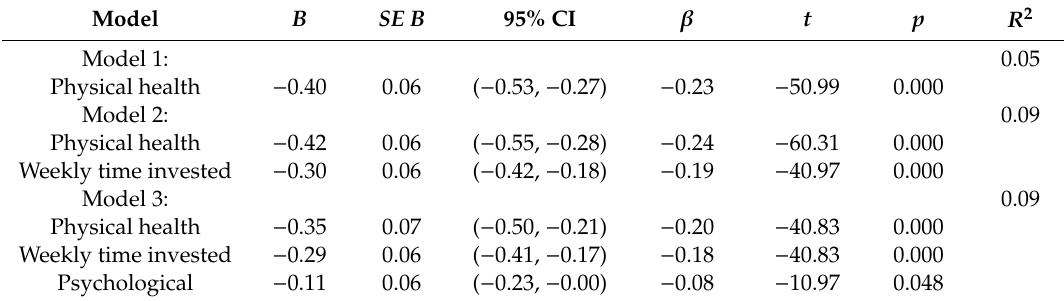
Table 3. Regression analysis summary for domains related to quality of life and participation in physical activity predicting